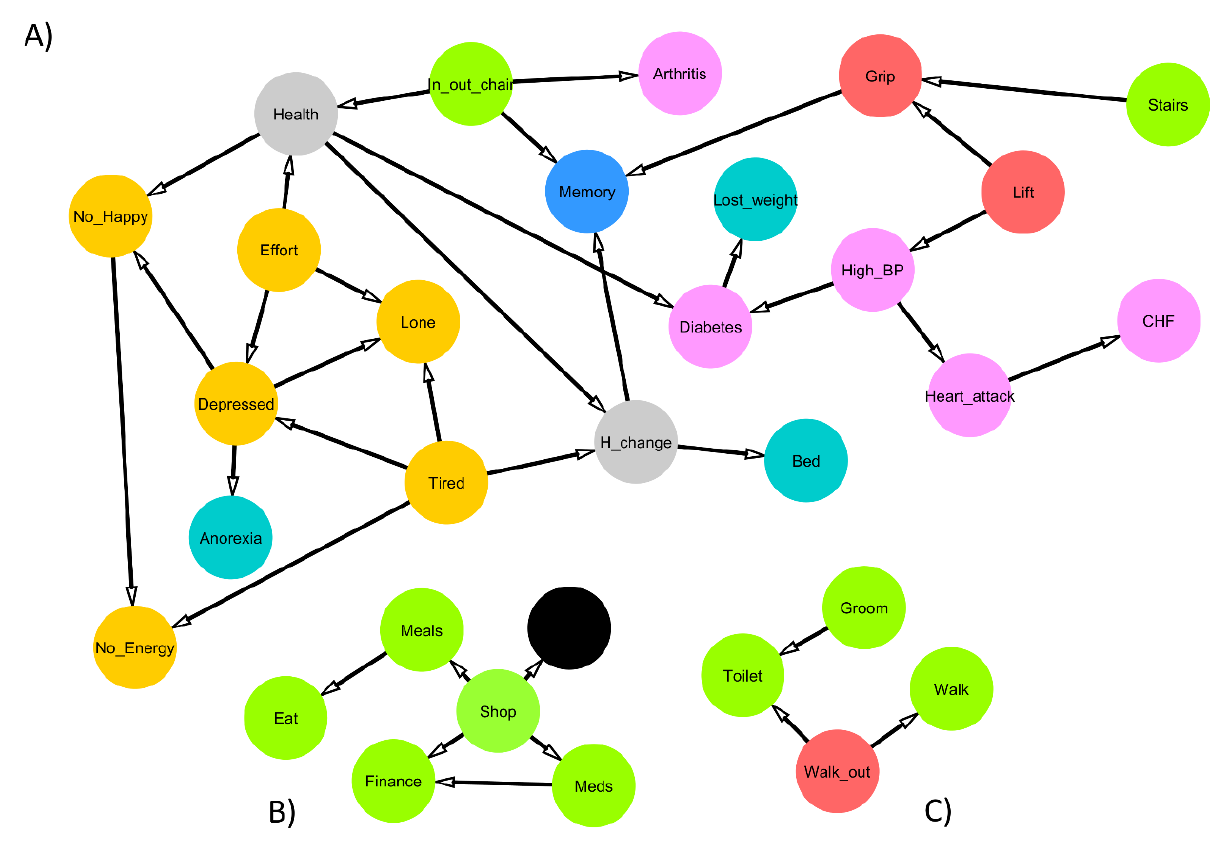
Figure 3. Network associated with the averaged Bayesian network for the frailty components and dead node induced by those arcs with a strength (both presence and direction) of 0.8 and more. Nodes are colored according to the following classification: black: Dead ; yellow: AS (Affective Status: No Happy, Lone, No energy, Depressed, Tired, and Effort ); light blue: symptoms ( Anorexia, Bed, and Lost_weight ); gray: SRH (Self-rated health: Health and H_change ); green: ADL-IADL (activities of daily living and instrumental activities of daily living: In_out_chair, Stairs, Shop, Walk, Eat, Groom, Meals, Meds, Finance, and Toilet ); orange: physical health ( Grip, Lift, and Walk_out ); pink: comorbidities ( CHF, Arthritis, Heart_Attack, Diabetes, and High_BP ); navy blue: cognition ( Memory ). ( A – C ) correspond to the three connected components associated with the network. Three clusters are independent of each other; since strength is 0.8 or more, arcs are in the same colour.